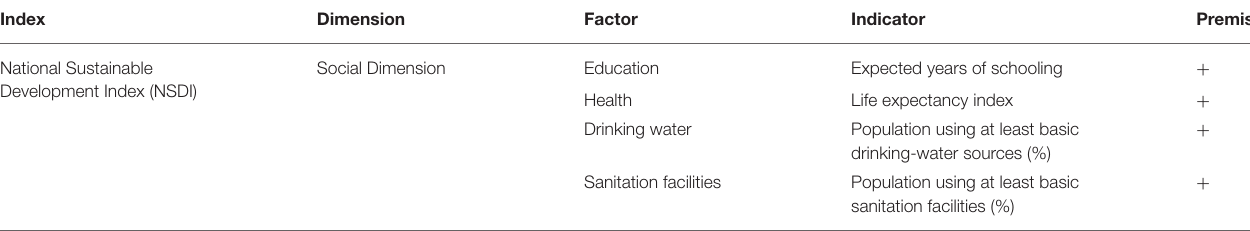
TABLE 1 | The social dimension of the National Sustainable Development